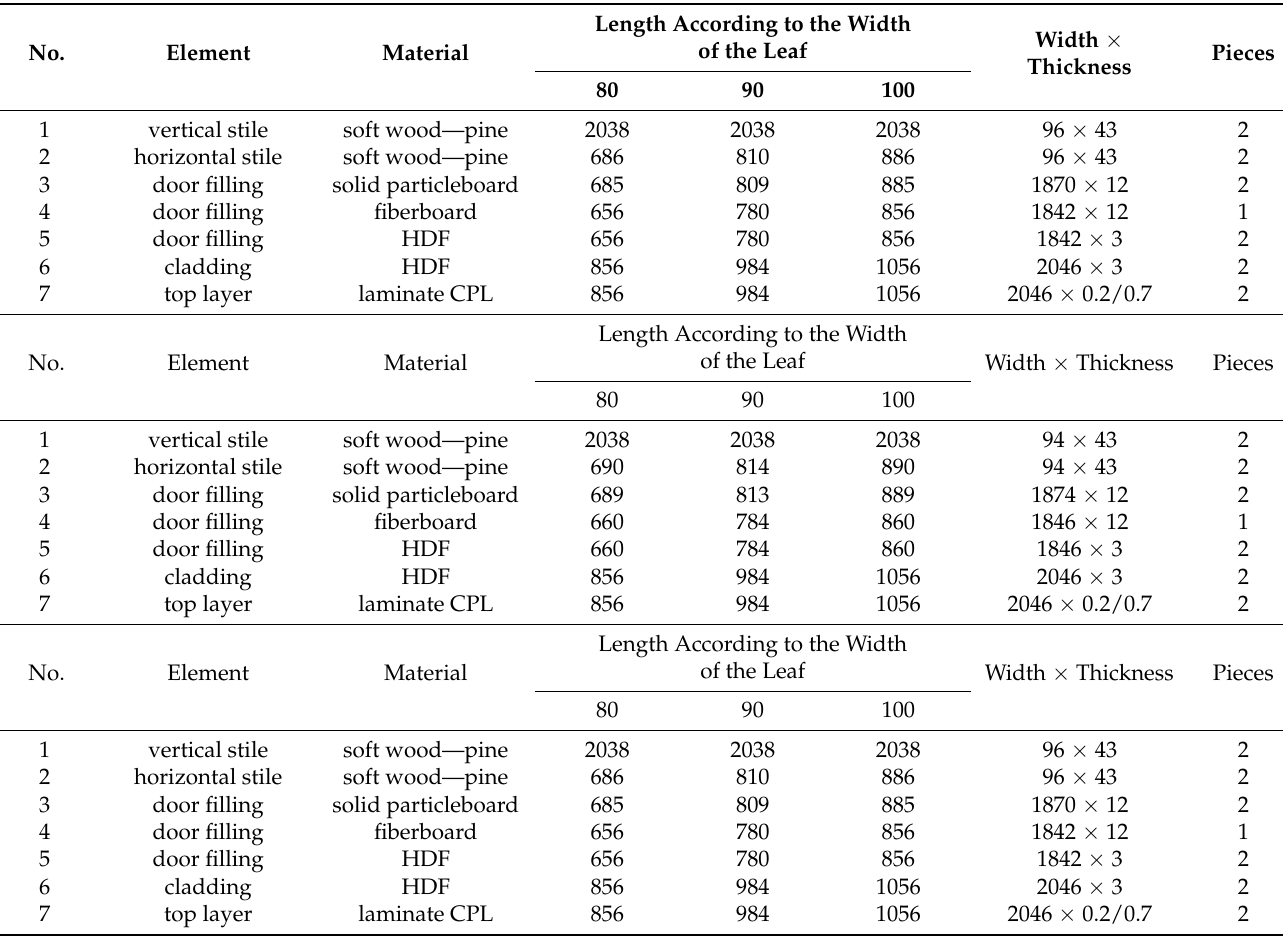
Table 1. Construction 1. Previously used values of machining allowances; reduced machining allowances, variant 1; variant